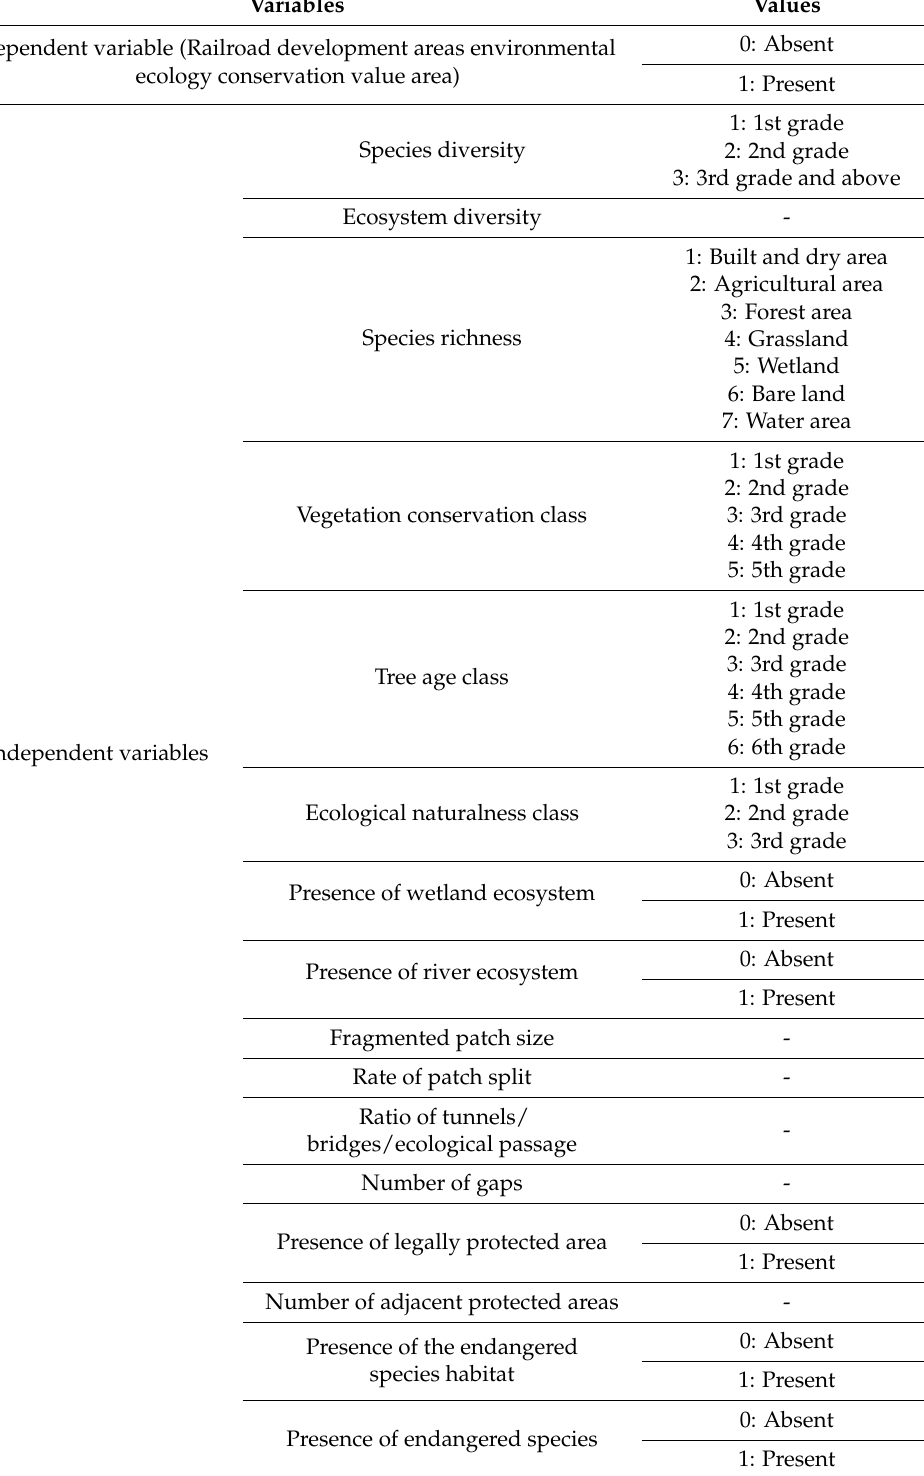
Table 1. Dependent and independent variables used for analysis of spatial information.